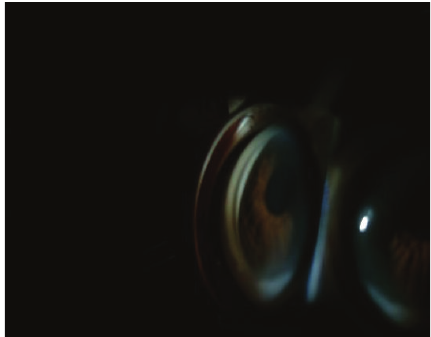
Figure 4: The iridocorneal angle is Grade 1 according to Shaffer classification.